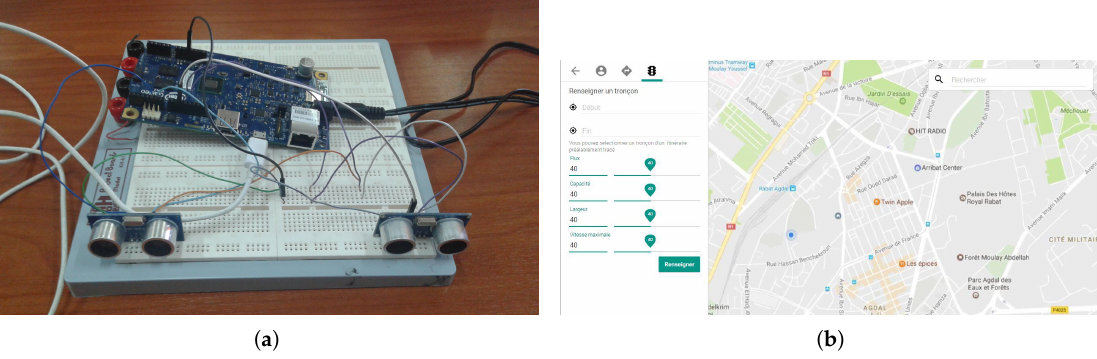
Figure 8. The main elements of the proposed prototype. ( a ) HC-SR04 ultrasonic sensors with Intel Galileo Gen 2; ( b ) Web Interface for inserting road